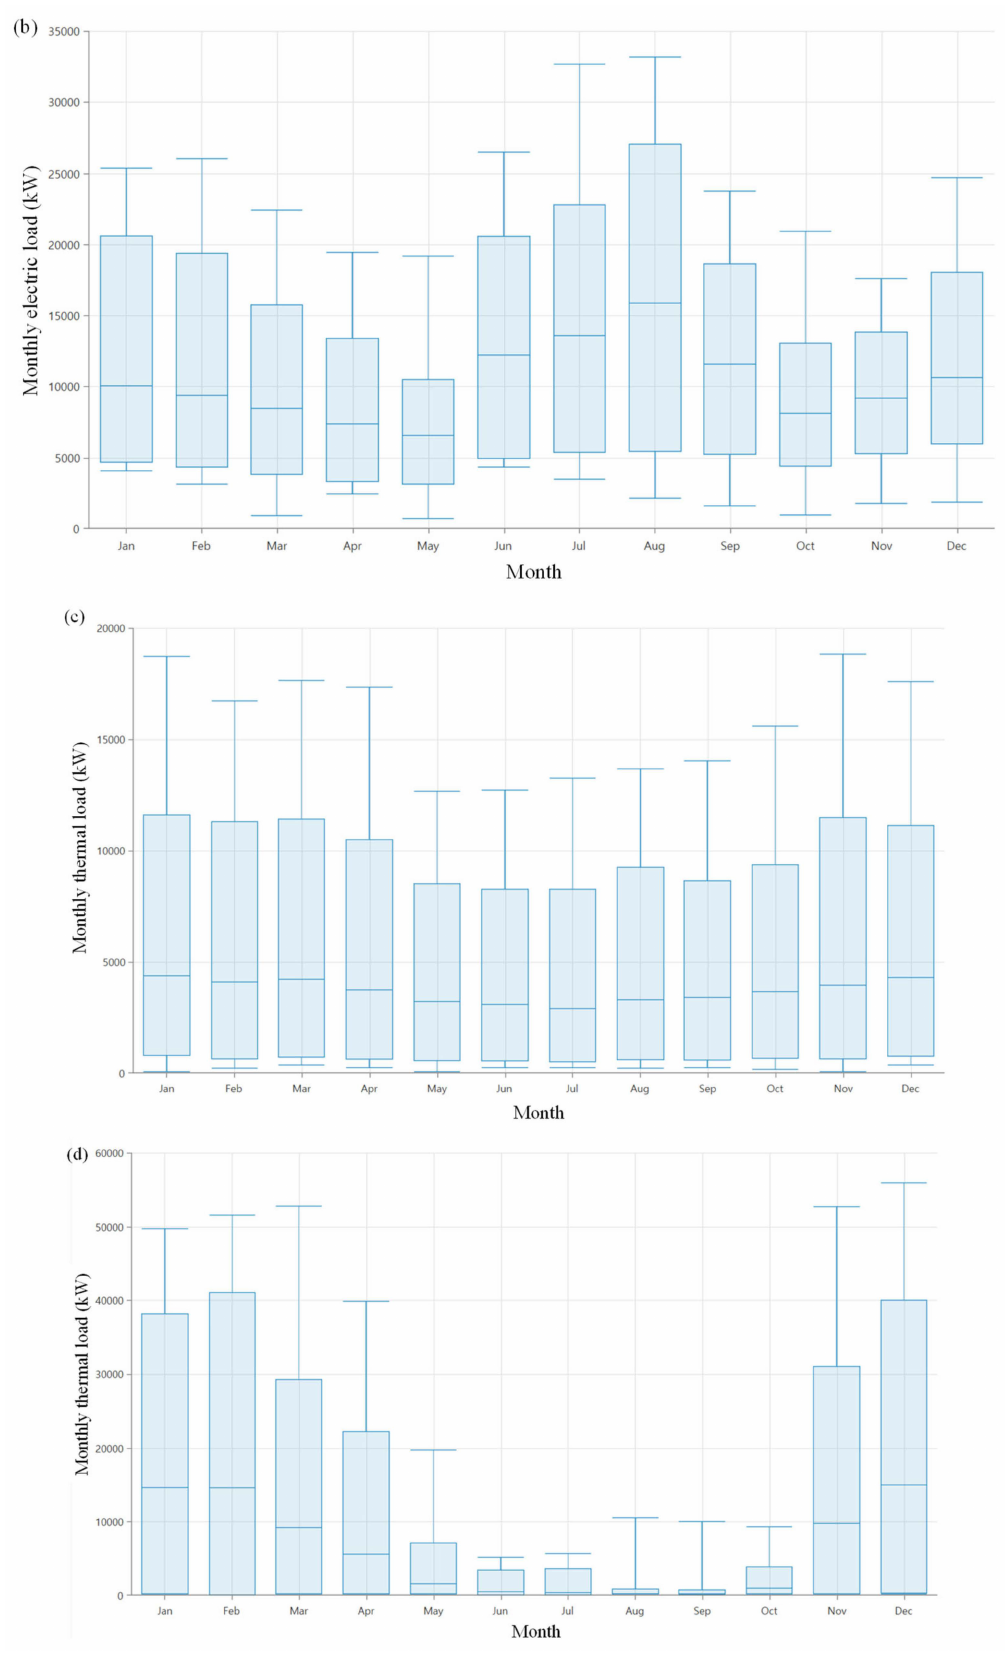
Figure 4. Monthly electric and thermal loads of the Sejong national pilot smart city: ( a ) electric load of residential buildings, ( b ) electric load of commercial buildings, ( c ) thermal load of residential buildings, ( d ) thermal load of commercial